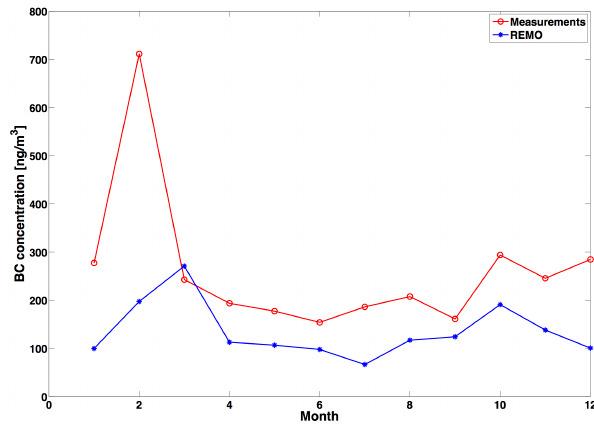
Fig. 5. Monthly medians of the black carbon concentrations, where the red circles represent the measurements and the blue stars the model results (Hyyti¨al¨a, 2005).